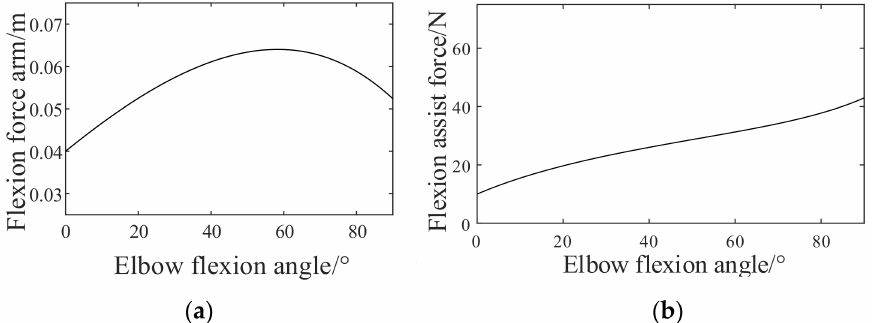
Figure 9. Force arm and force of flexion assist cable actuator. ( a ) Force arm. ( b ) Force on the flexion cable